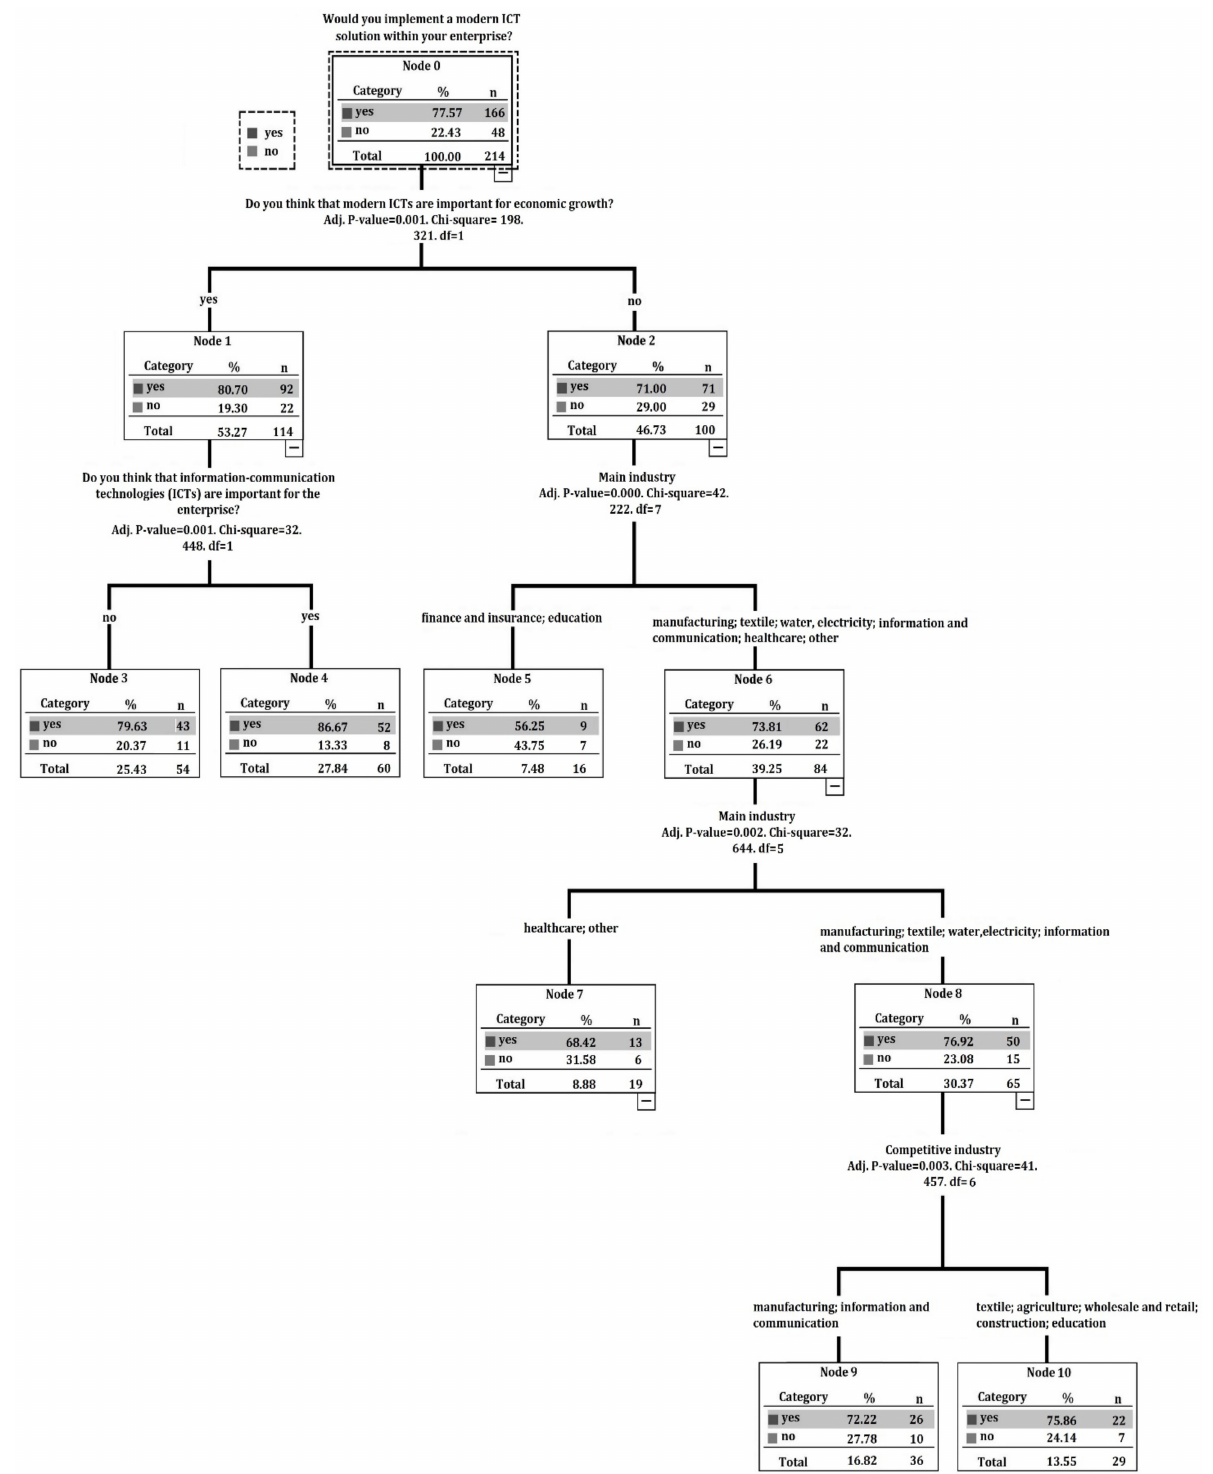
Figure 4. QUEST algorithm decision tree for predicting intentions on ICT solution